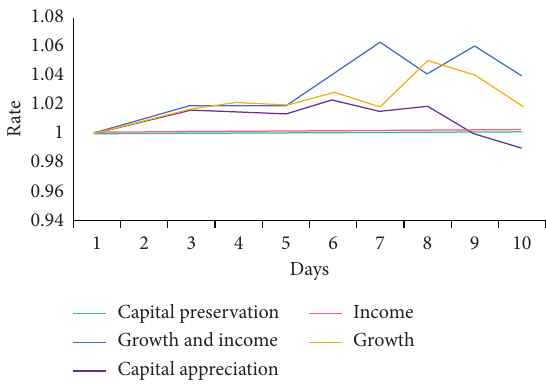
Figure 10: Comparison of five risk-level investment portfolios and performance benchmarks. Table 3: Backtest results of the five major risk grade portfolios.